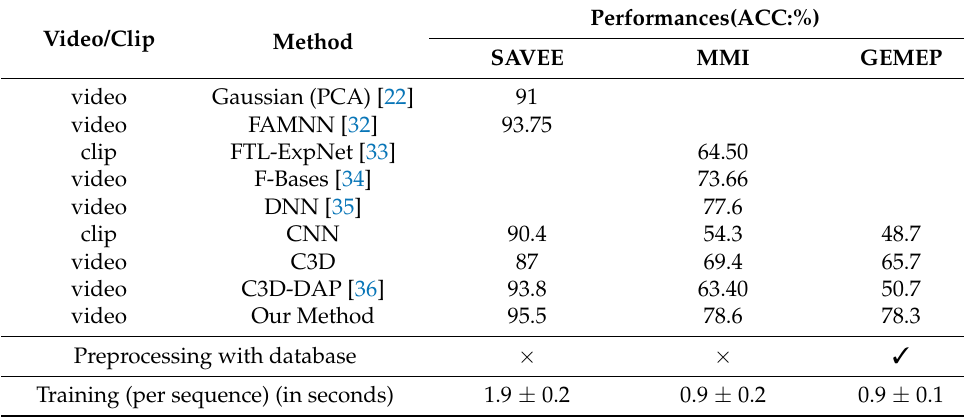
Table 3. The performance of different methods on three databases.